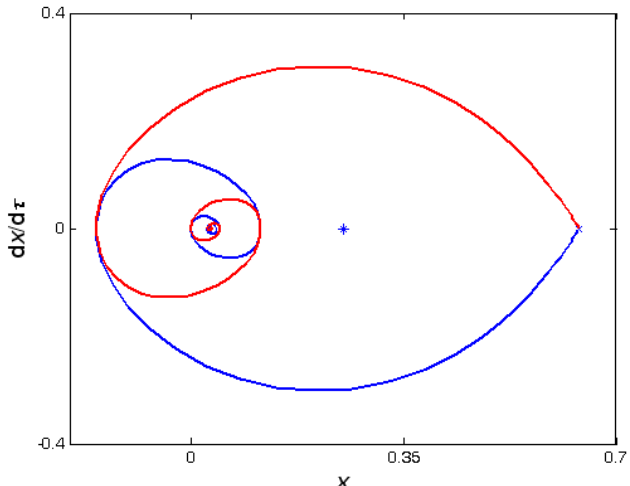
Figure 11. Heteroclinic orbits with and